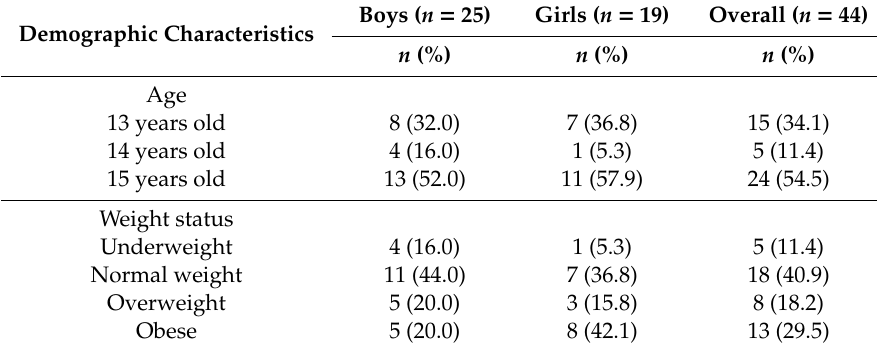
Table 1. Characteristics of subjects n (%).